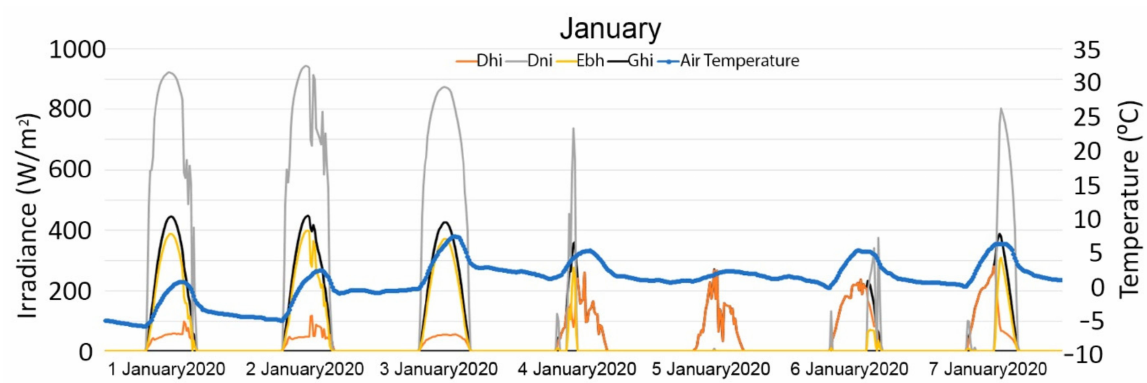
Figure 3. Solar irradiances and outdoor temperature in January.